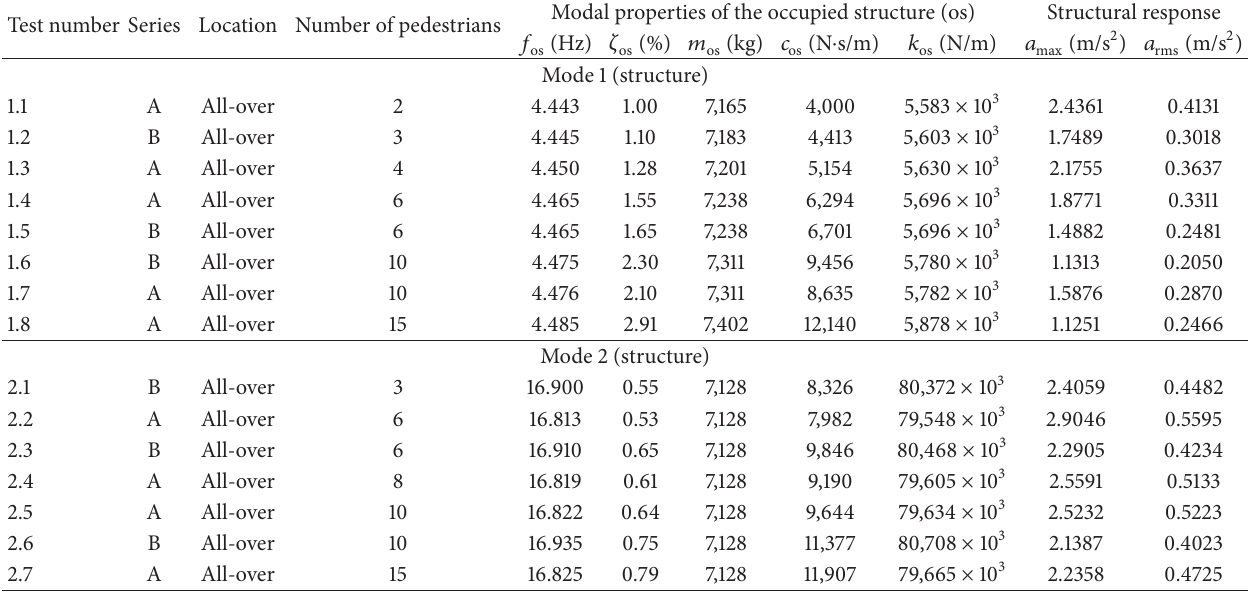
Table 1: Modal properties of the occupied structure (os) for different group sizes. Test number Series Location Number of pedestrians